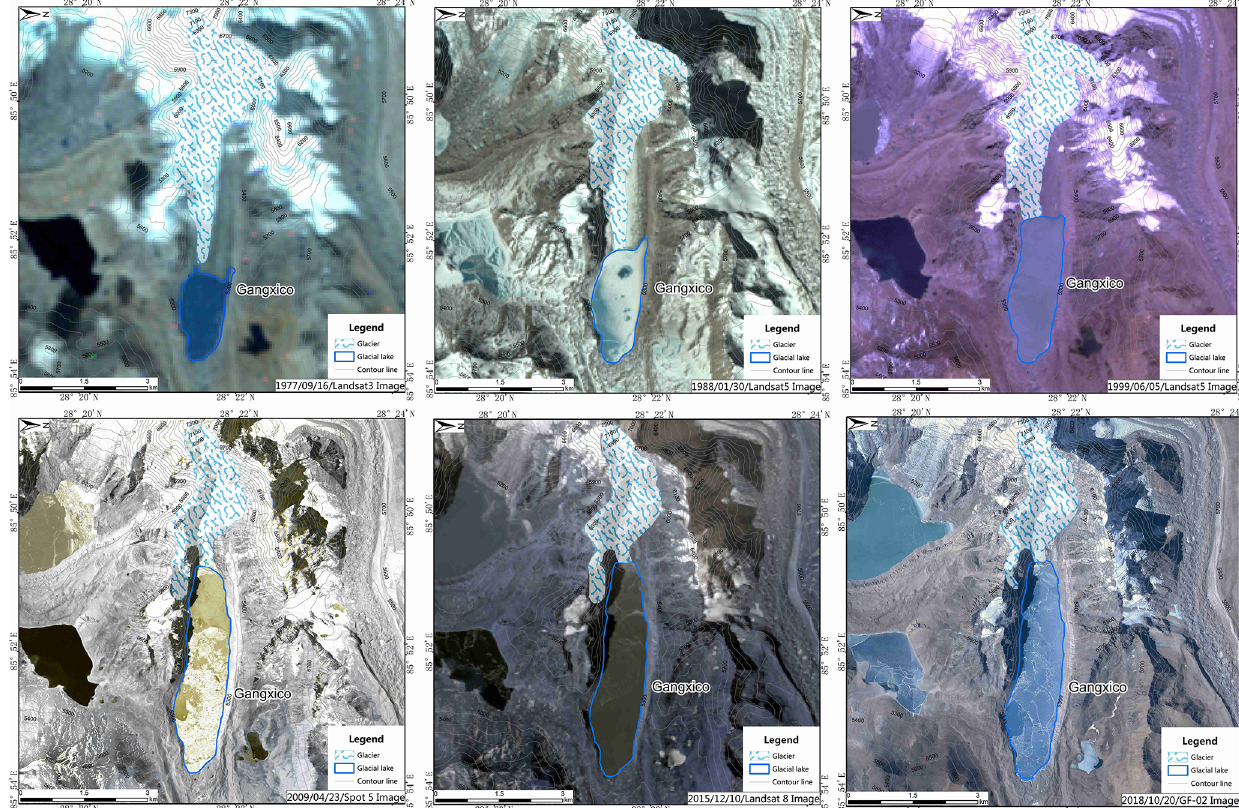
Figure 5. A comparison of the area change between the Gangxico Lake and its connected